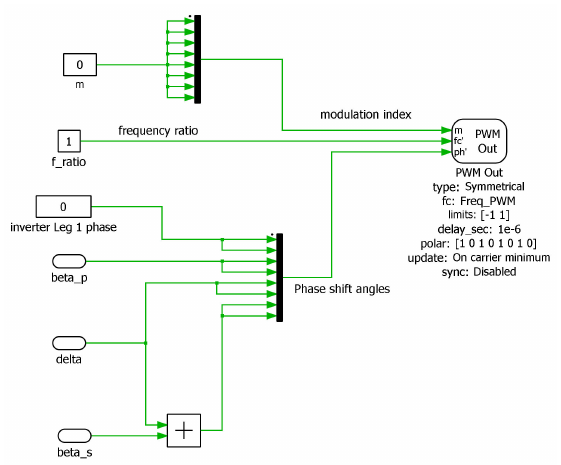
Figure 10. PLECS-RT BOX phase shift PWM modulator signal connection and configuration.